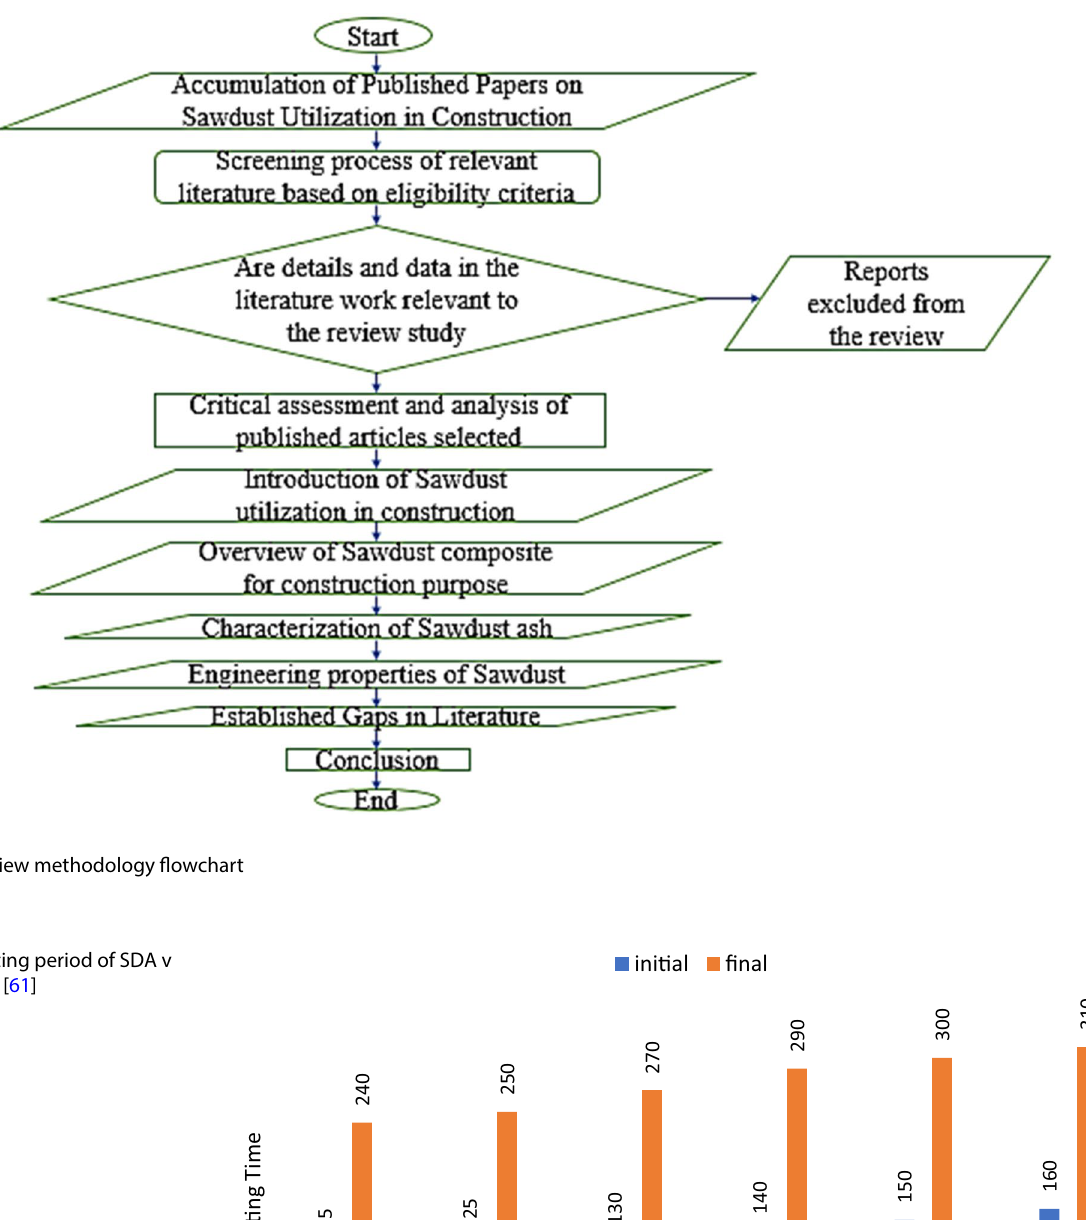
Fig. 3 Setting period of SDA v OPC paste